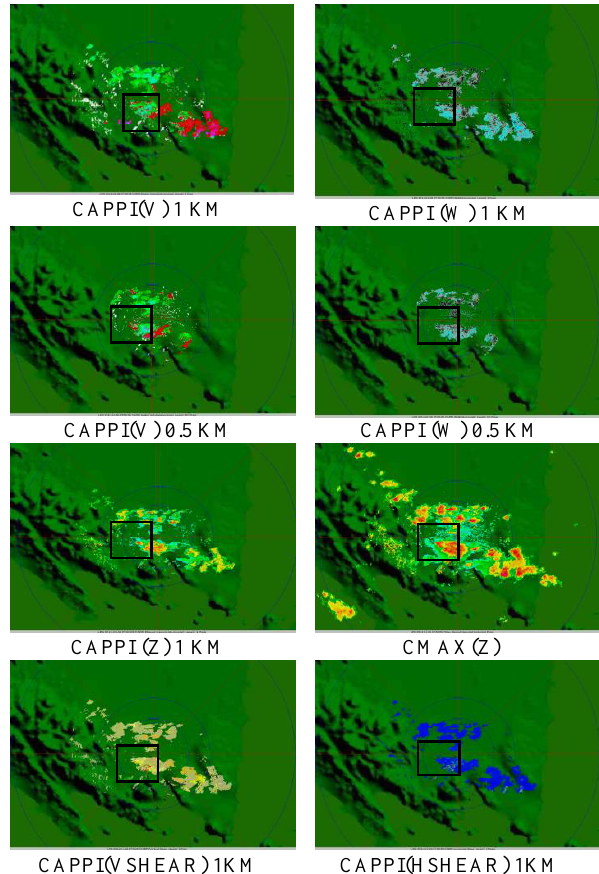
Figure 1. Radar product at whirl wind occurence in Pringsewu